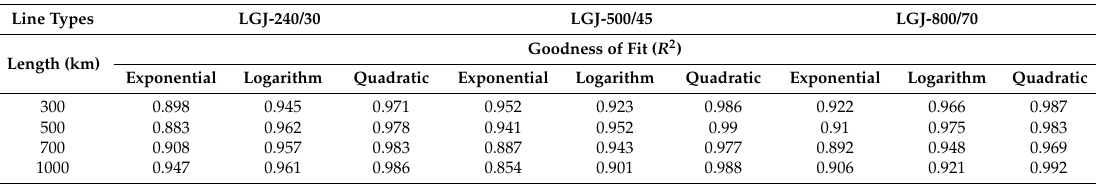
Table 2. The R 2 of different lines with different